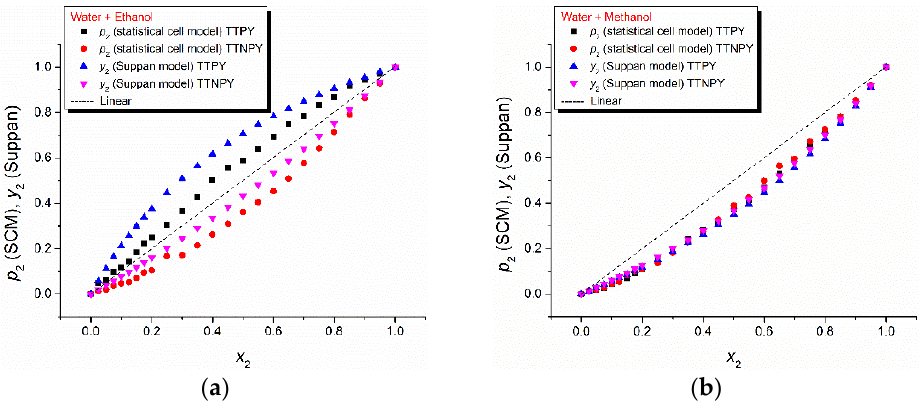
Figure 12. Local mole fractions calculated through statistical cell model (SCM) ( p 2 ) and Suppan’s model ( y 2 ) as a function of bulk mole fraction of ethanol ( a ) and methanol ( b ), respectively.